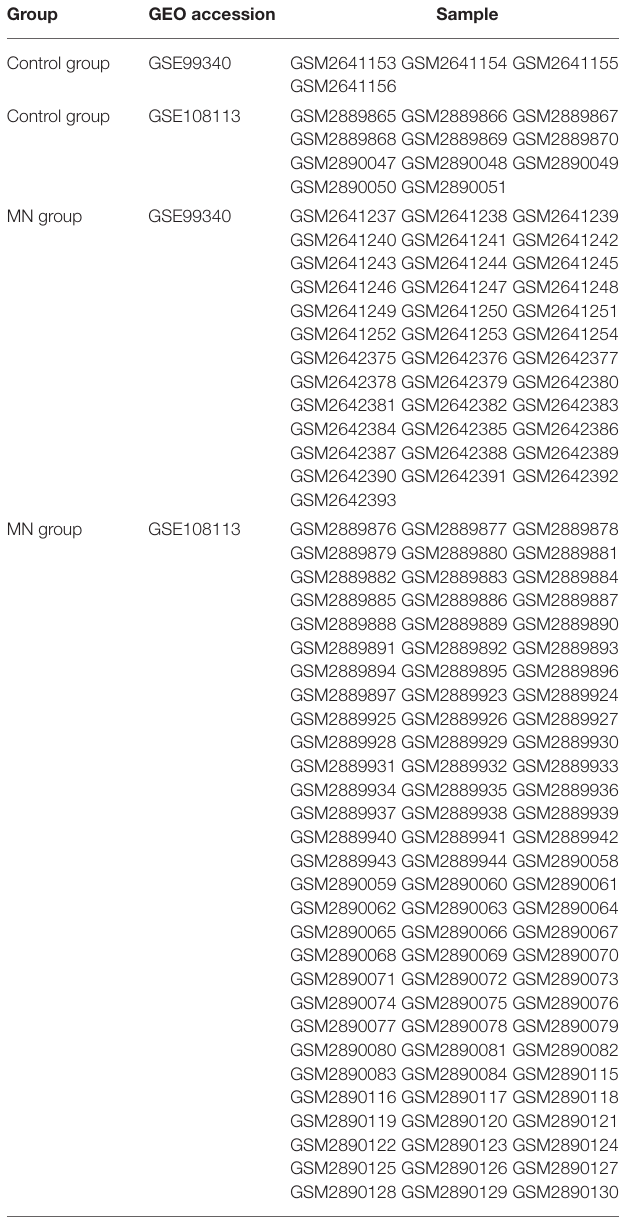
TABLE 1 | Sample number and group information. Group GEO accession